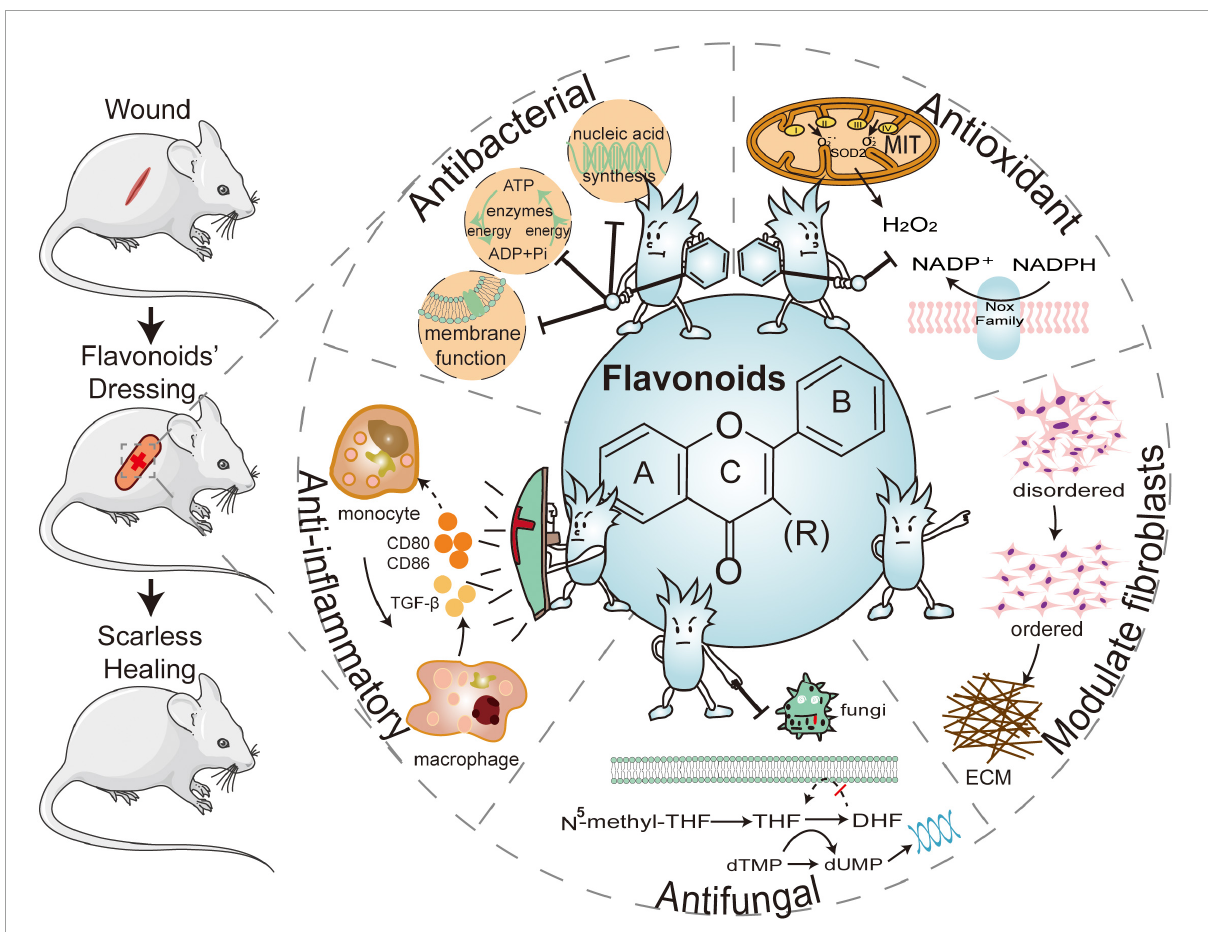
FIGURE1 The five major effects of flavonoid-laden dressings are: the hydroxyl substituents of flavonoids can inhibit bacterial nucleic acid synthesis, cell membrane function, and energy metabolism to provide antibacterial functions, as well as the phenolic hydroxyl groups can combine with reactive oxygen species (ROS) to adsorb surrounding free radicals and exert an antioxidant effect. Flavonoids can reduce inflammatory factors, regulating fibroblasts, inhibiting extracellular matrix (ECM) deposition, and promoting scarless healing. Flavonoids can also be antifungal by interfering with folate metabolism and inhibiting biofilm formation. ATP, adenosine triphosphate; ADP, adenosine diphosphate; CD80, cluster of differentiation 80; CD86, cluster of differentiation 86; TGF- β 1, transforming growth factor- β 1; THF, tetrahydrofolate; DHF, dihydrofolate; dTMP, deoxythymidine phosphate; dUMP, deoxyuridine phosphate; ECM, extracellular matrix; NADPH, nicotinamide adenine dinucleotide